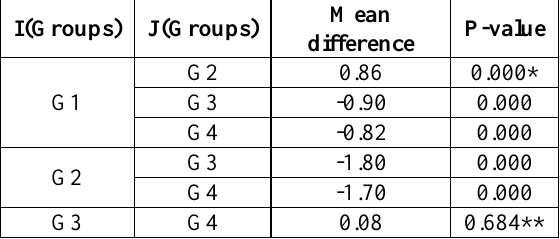
Table 4: LSD test of groups of this